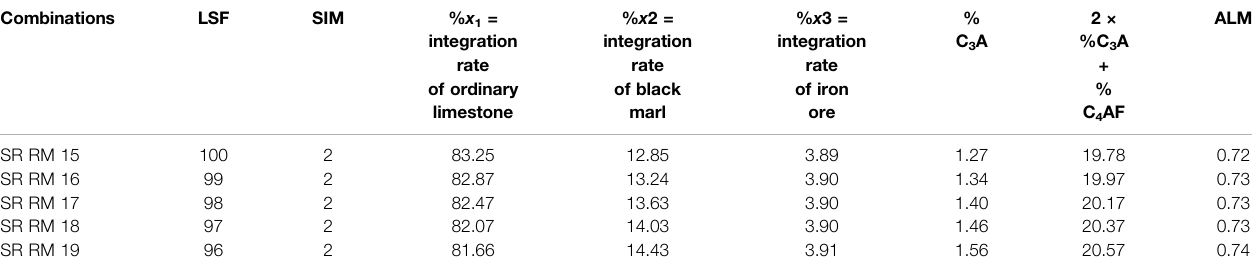
TABLE 7 | SR Portland raw meal combinations by using three raw materials (substituting the marl mix with black marl).